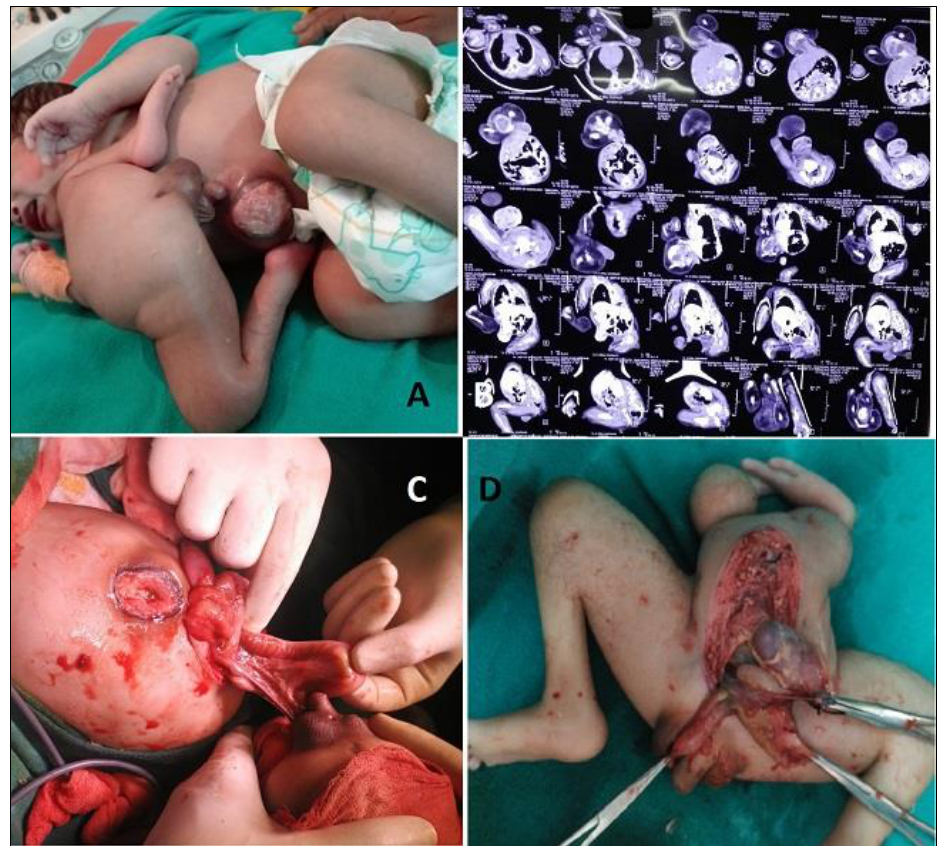
Figure 1: A) Epigastric heteropagus with well developed lower limb, phallus, scrotum and anal dimple in the parasitic twin with omphalocele in the autosite. B) CECT. C) Intraoperative details showing 20 cm of bowel present closed at both ends. D) Resected specimen showing bladder, intestine connected to the bladder and solitary kidney with